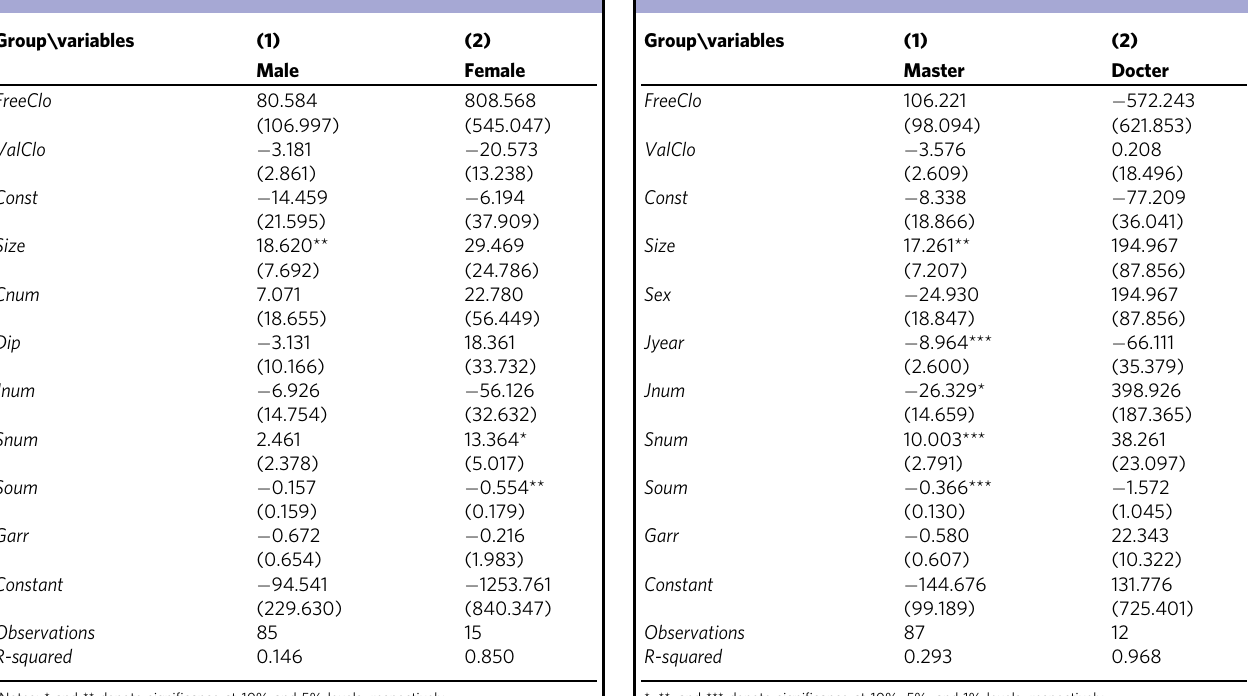
Table 6 Regression results from a gender heterogeneity perspective.